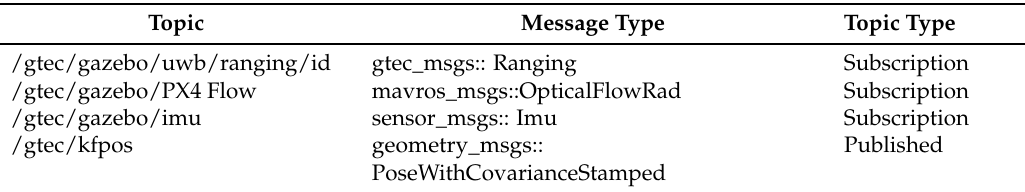
Table 4. Node kfpos. The id in the ultra-wideband (UWB) range topic route corresponds to the tag